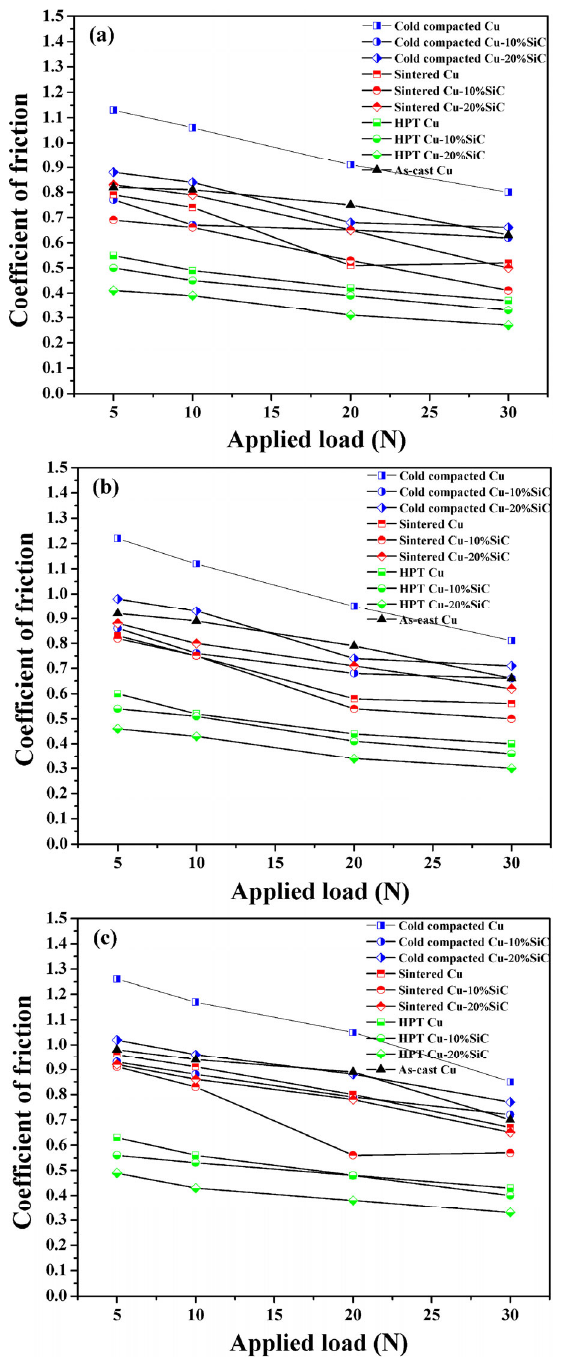
Fig. 9 The effect of the applied load on the average value of the COF of the as-cast Cu, cold compacted, sintered, and HPTed Cu and Cu-SiC samples under different sliding distances of (a) 500, (b) 1,500, and (c) 2,500